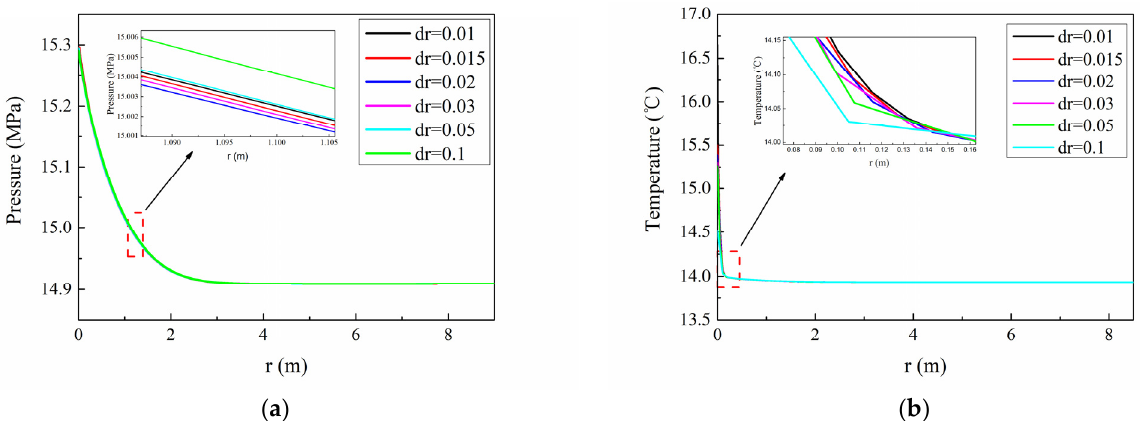
Figure A1. Comparison of the pressure and temperature distribution curves at 25 m from the bottom of the reservoir in the simulation results with lateral element spacing parameter values of 0.01 m, 0.015 m, 0.02 m, 0.03 m, and 0.05 m: ( a ) pressure distribution; ( b ) temperature distribution.